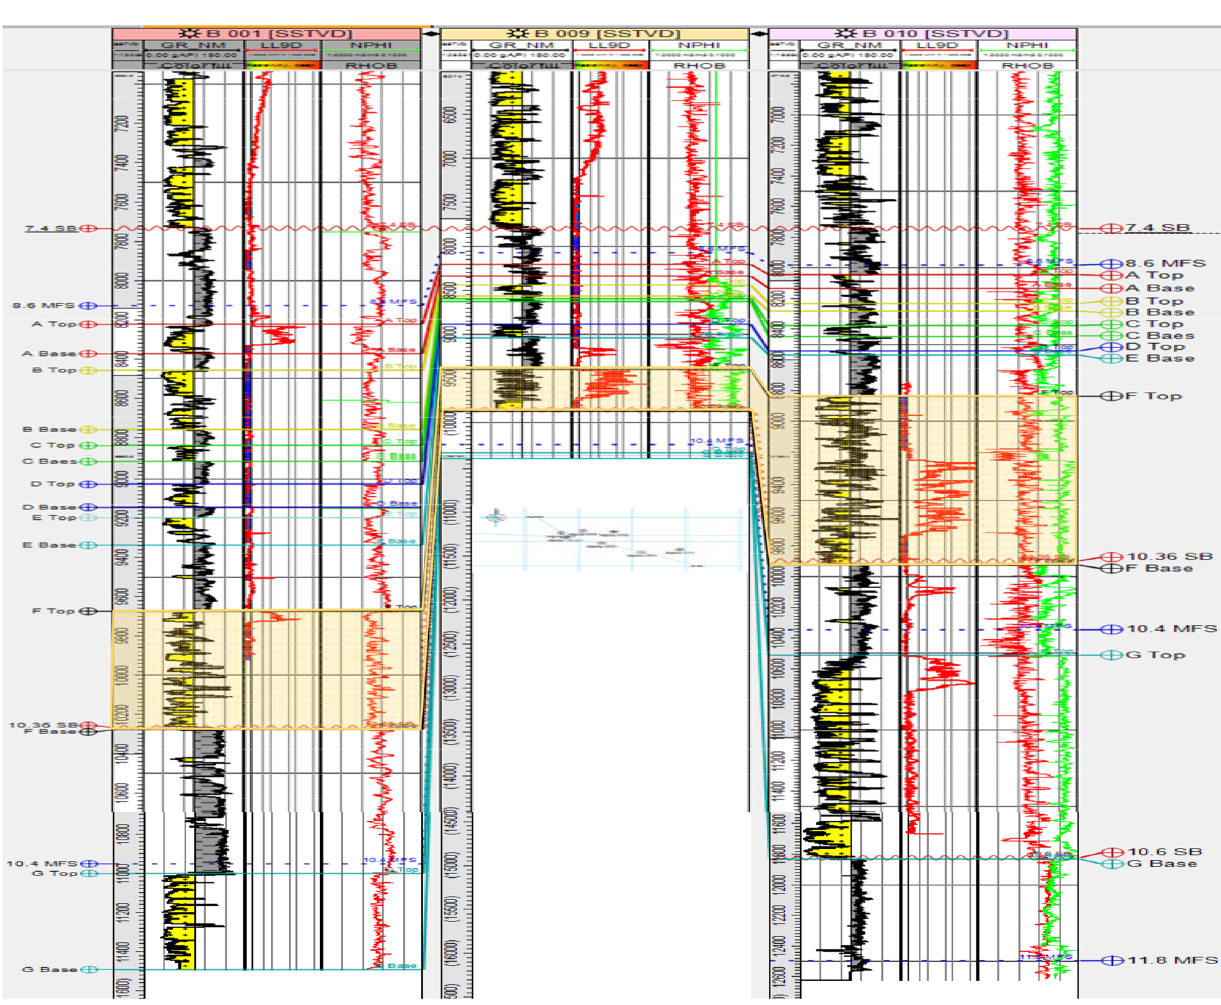
Fig. 4 Reservoir correlations for Bruks Field along the strike